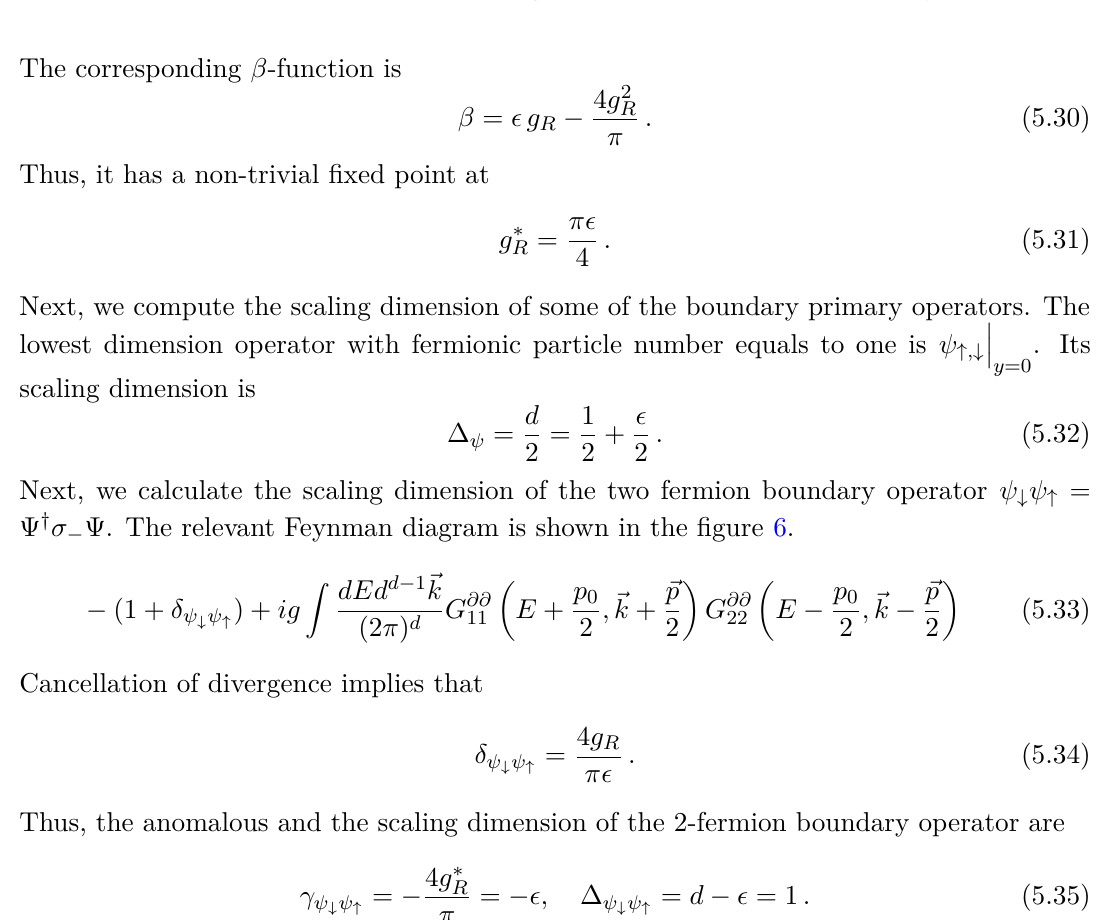
Figure 6 . One loop computation of scaling dimension of two-fermion boundary